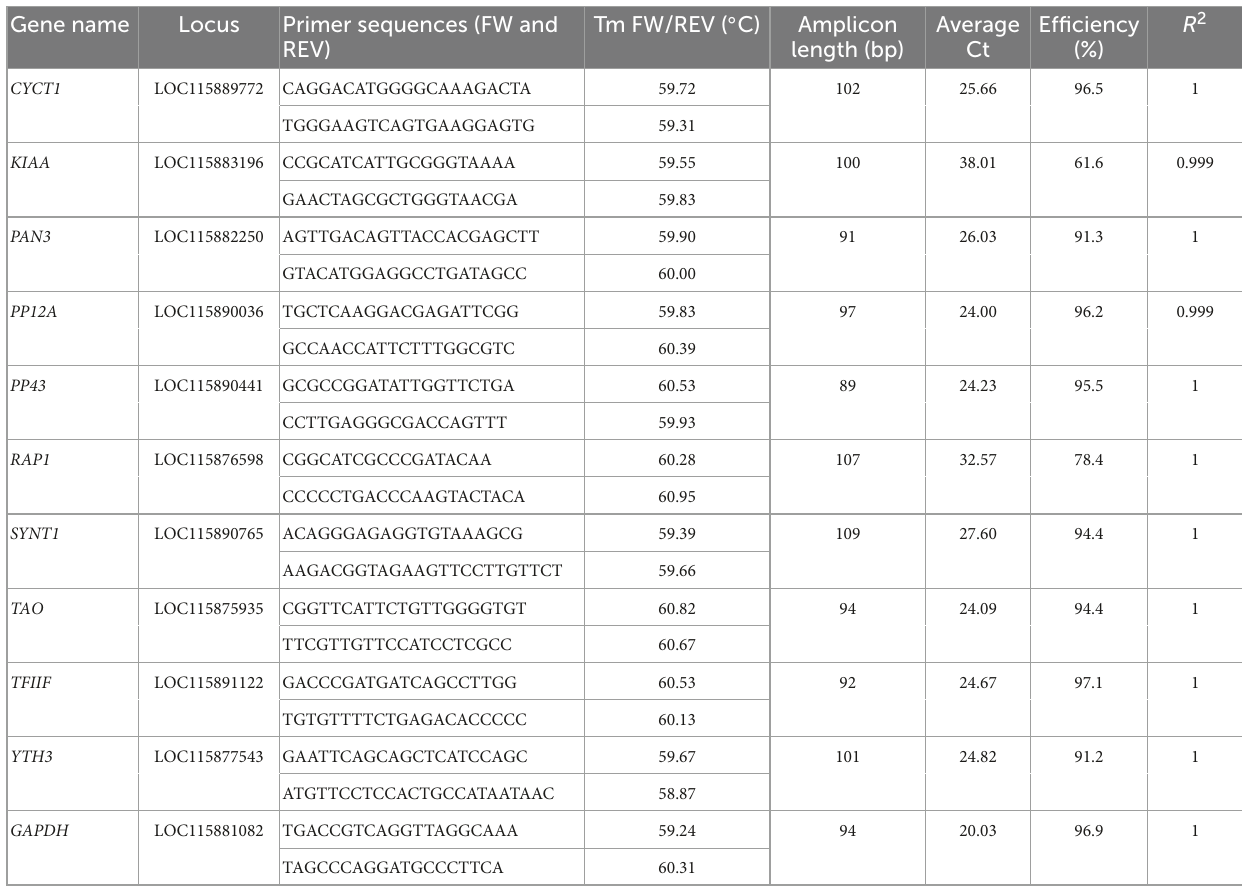
TABLE 2 Primers and amplification parameters used for each candidate reference gene selected for qRT-PCR